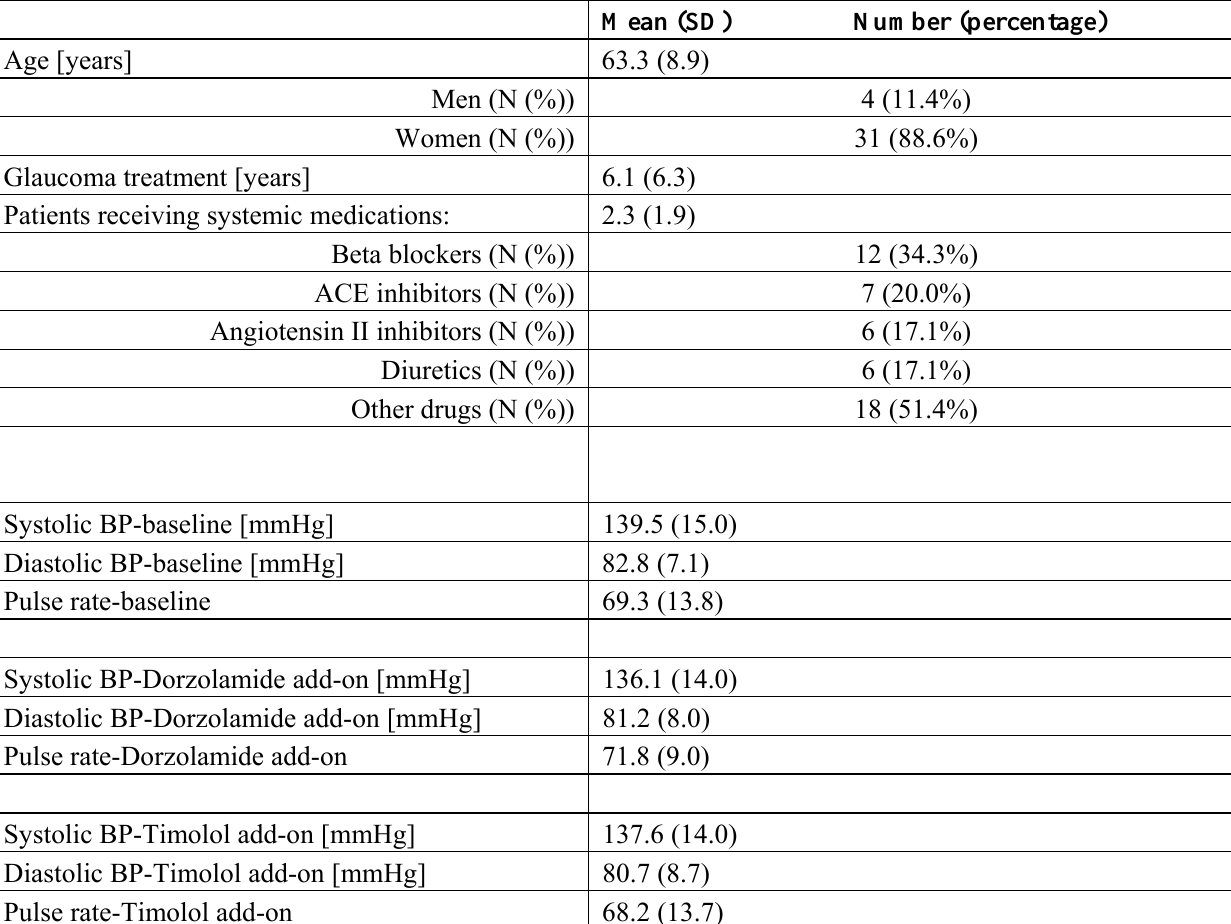
Table 1. Patient